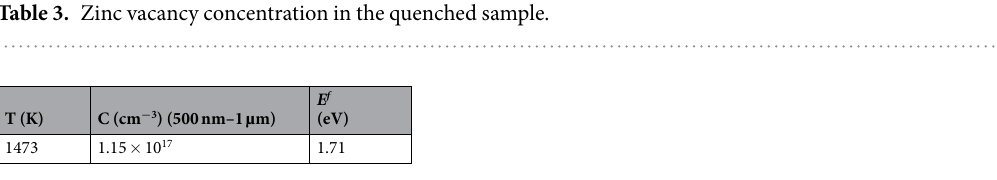
Table 4. Zinc vacancy formation energy under quenched conditions.